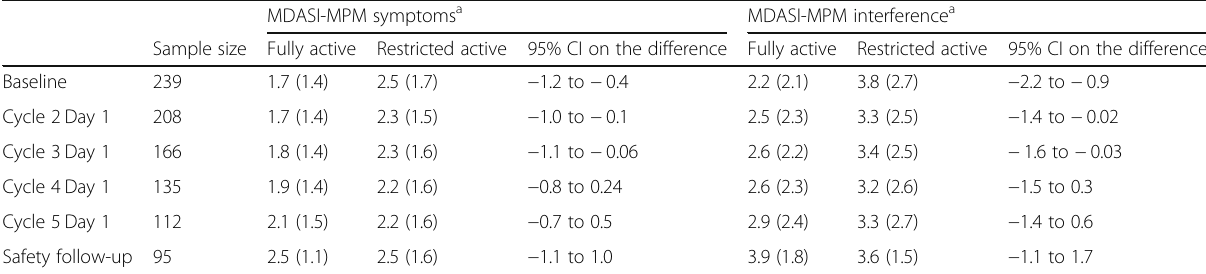
Table 4 Known-group validity by ECOG PS at various timepoints MDASI-MPM symptoms a MDASI-MPM interference a